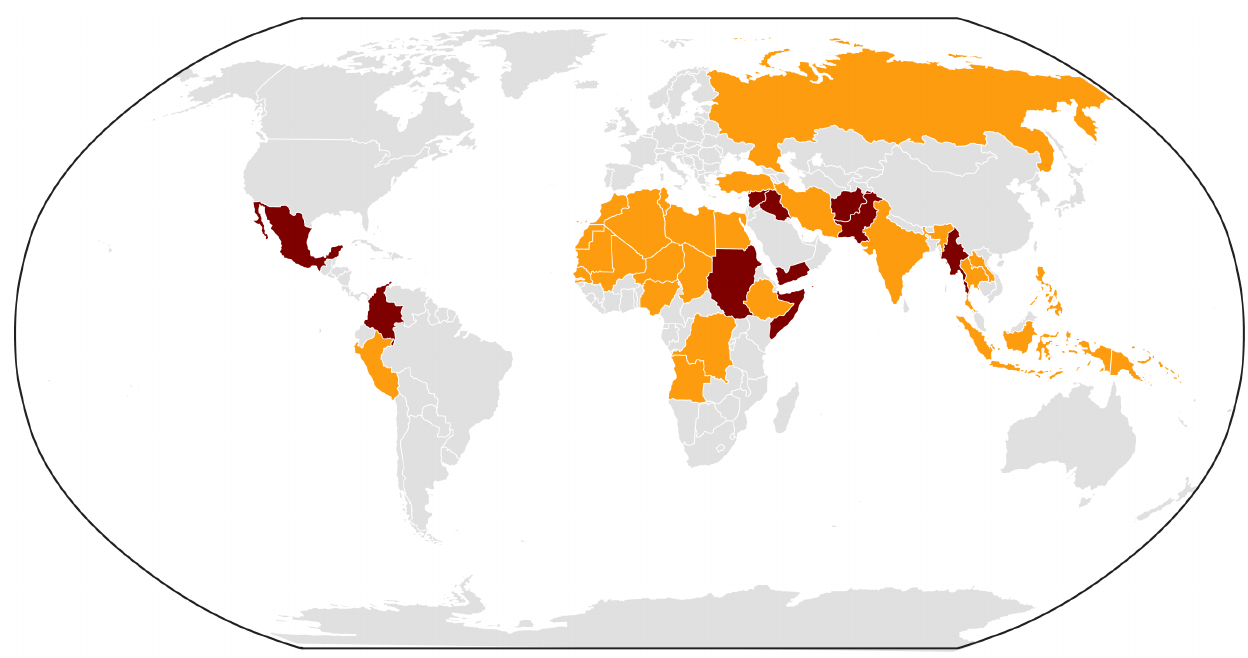
Figure 1. Ongoing conflicts around the world. Dark red: Major wars, 1,000 + deaths per year. Orange: Minor skirmishes and conflicts, fewer than 1,000 deaths per year.